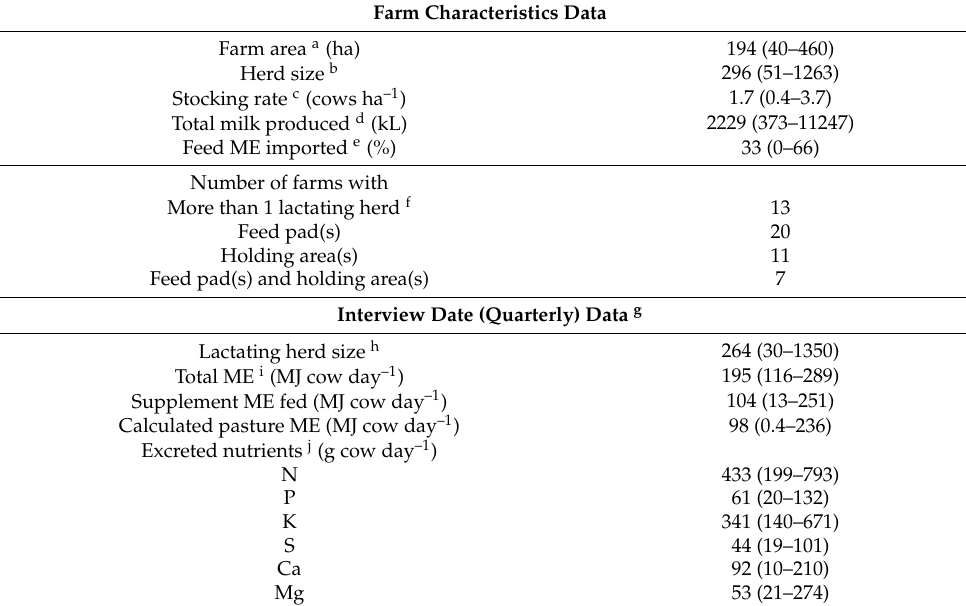
Table 1. Mean (range) characteristics of 43 grazing system dairy farms as well as data collected on five interview dates for lactating cows including herd sizes, diet metabolisable energy, and nutrients